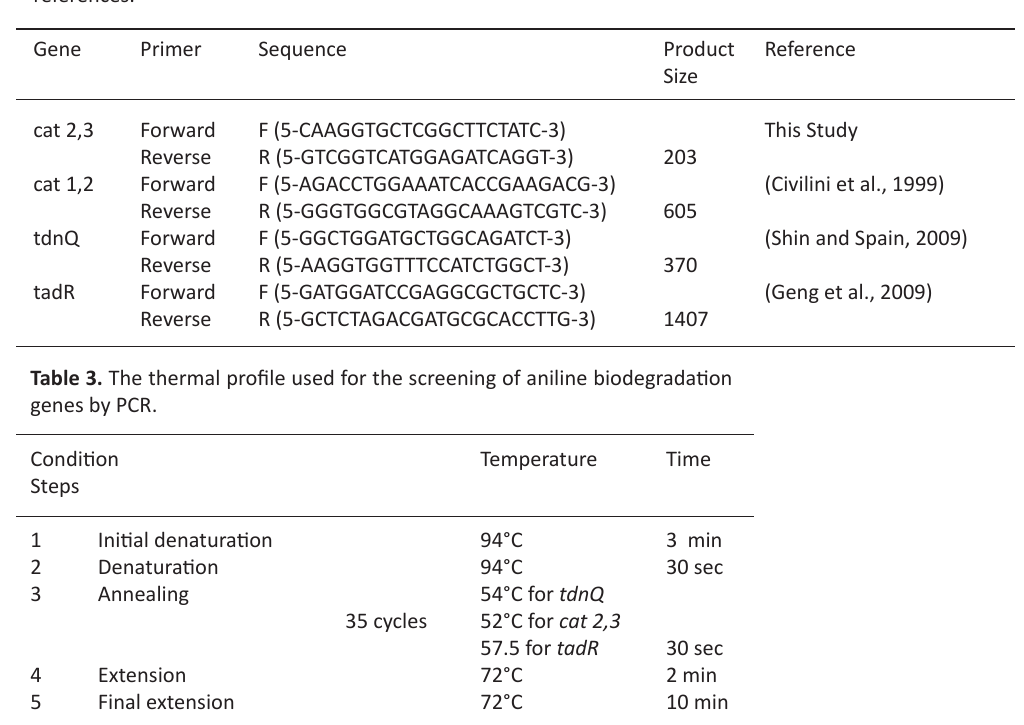
Table 2. List of primer pairs used in the study, their sequences, their expected product size and their references.